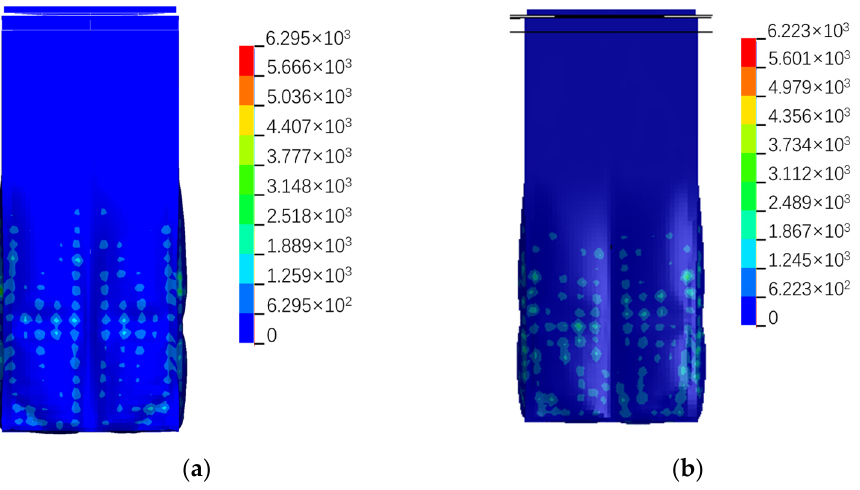
Figure 15. The interaction force ( a ) initial design and ( b ) optimal design.